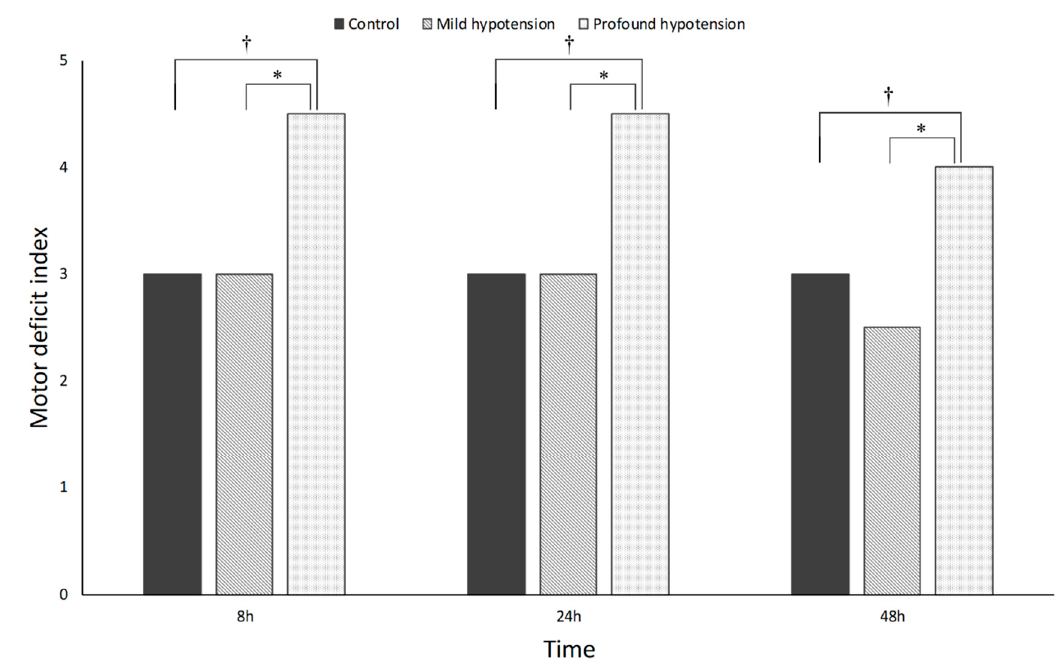
Figure 2. Motor deficit index at 8, 24, and 48 h after reperfusion. The profound hypotension group had significantly higher MDI (motor deficit index) scores than the mild hypotension and control groups. p < 0.001 (*, † ) by Mann-Whitney U test.